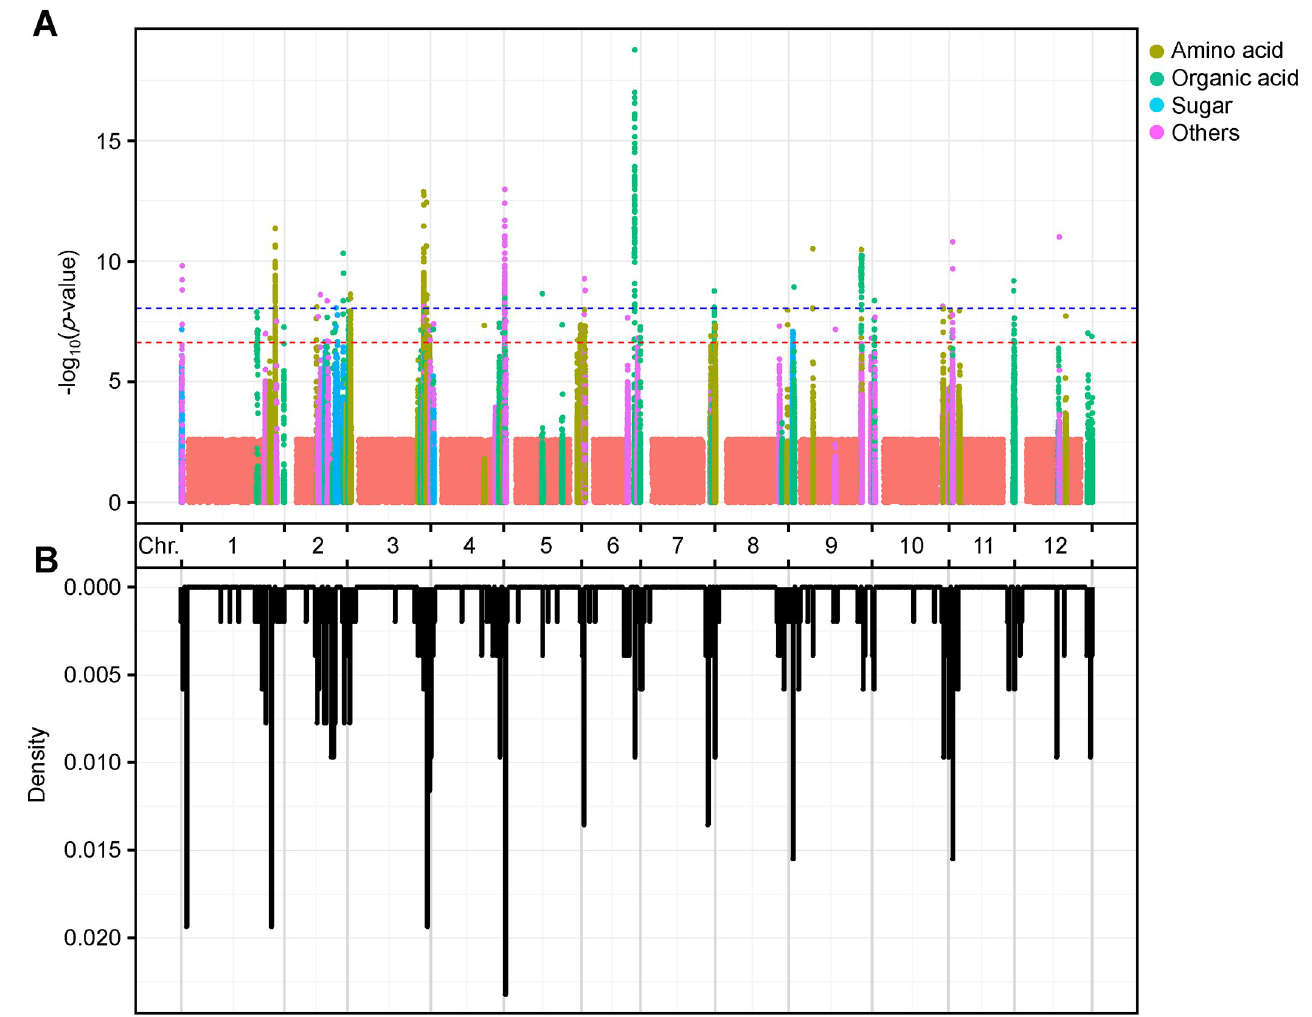
Fig 1. Overview of mGWAS results in this study. (A) The strength of the association of metabolites is indicated as the negative logarithm of the P value for the CMLM model. All metabolite–SNP associations with P values < 2.4 × 10 − 7 are plotted against genome location at 1-Mb intervals. Red and blue horizontal dashed lines in the manhattan plots indicate the genome-wide suggestive ( P values < 2.4 × 10 − 7 ) and significant ( P values < 1.2 × 10 − 8 ) threshold, respectively. Amino acids are indicated by olive green circles. Organic acids are indicated by light green circles. Sugars are indicated by light blue circles. Other compounds are indicated by pink circles. (B) Distribution density of mGWAS signals across the tomato genome (SL2.50). mGWAS, metabolomic genome wide association analyses.